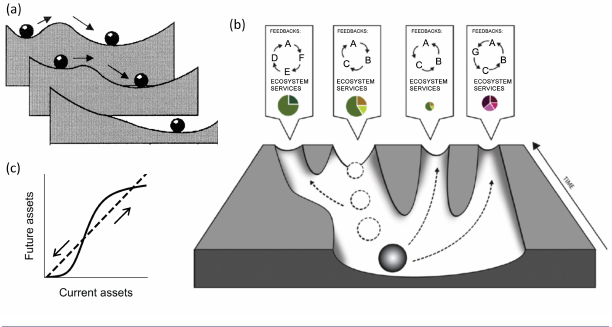
Ball-and-cup diagrams displaying a regime shift. Stable states occur at the bottom of the landscape’s “valleys”. Reproduced from Gunderson (2000). (B) Expanding the ball-and-cup diagram to trajectories of ecosystem services. Reproduced from Enfors (2013). (C) The S-curve of economic poverty trap models. A fixed point occurs when future assets is the same as current assets, that is, when the solid line crosses the dashed diagonal line; this S-curve shows a stable “poor“ and “not-poor “ states separated by an unstable state. Modified from Lade et al.